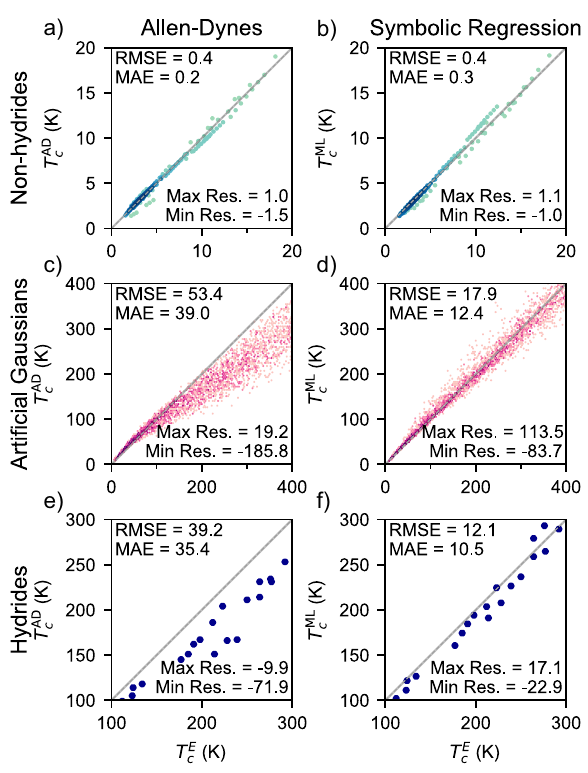
Fig. 5 Comparison of predictions using the Allen – Dynes equation and the new symbolic-regression corrections. The model T Model is c such that accurate predictions lie plotted against the Eliashberg T E c on the gray 1:1 line. a , b Non-hydride and c , d arti fi cial Gaussian panels depict the training error while e , f hydride 35 – 37 panels show extrapolative capacity. The non-hydride and arti fi cial Gaussian panels are colored by the log-density of points. We report the root-mean-square error (RMSE), mean-absolute error (MAE), max- imum residual, and minimum residual values in Kelvin. The maximum residual corresponds to the largest overprediction while the minimum residual corresponds to the largest under- prediction. The two multiplicative factors obtained from symbolic regression improve the prediction compared with the two multi- plicative factors of the Allen – Dynes formula, particularly for the higher T c systems.